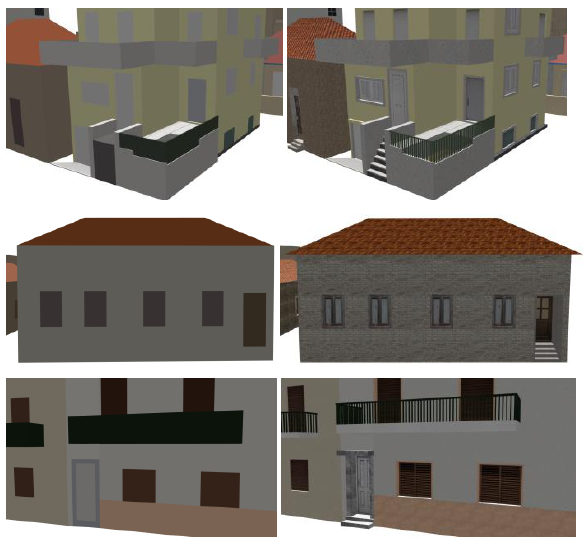
Figure 7. 3D views of the building models of an urban block at LoD2 (left) and LoD3